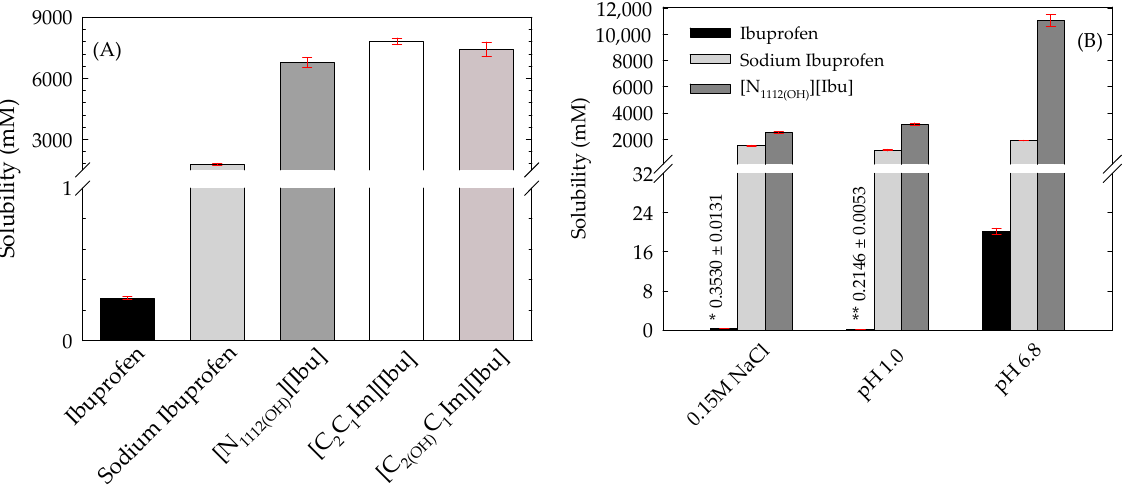
Figure 1. Solubility of ibuprofen, ibuprofen sodium salt and ibuprofen-based ILs in water ( A ). Solubility of ibuprofen, ibuprofen sodium salt and cholinium-based API-ILs in isotonic ionic strength aqueous solution (0.15 M NaCl), simulated gastric fluid (pH 1.0) and simulated intestinal fluid (pH